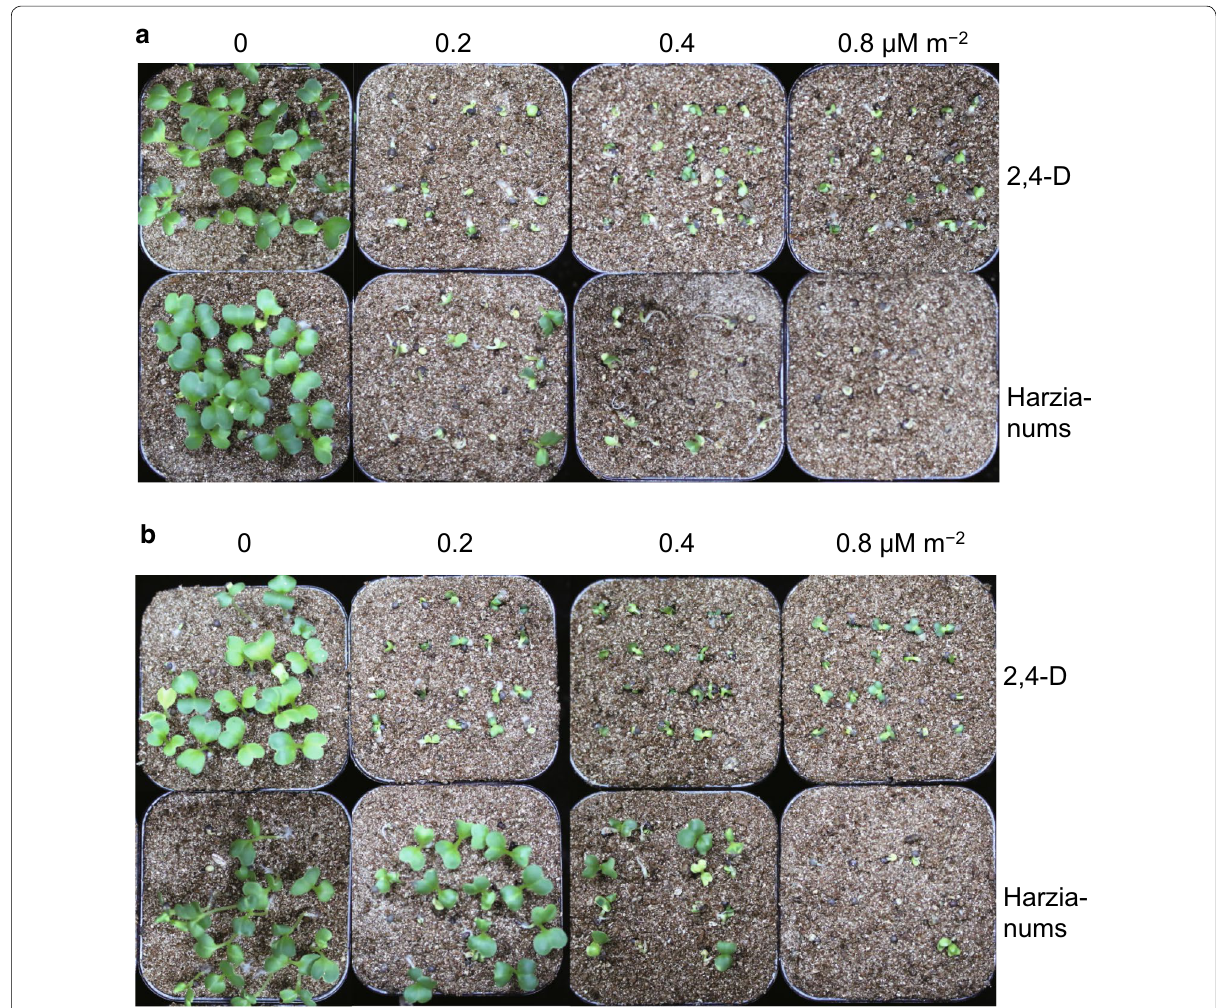
Fig. 2 The herbicidal activities of HA and HB ( 1 – 2 ) on B. chinensis in pot assays in a pre- and b post-emergence